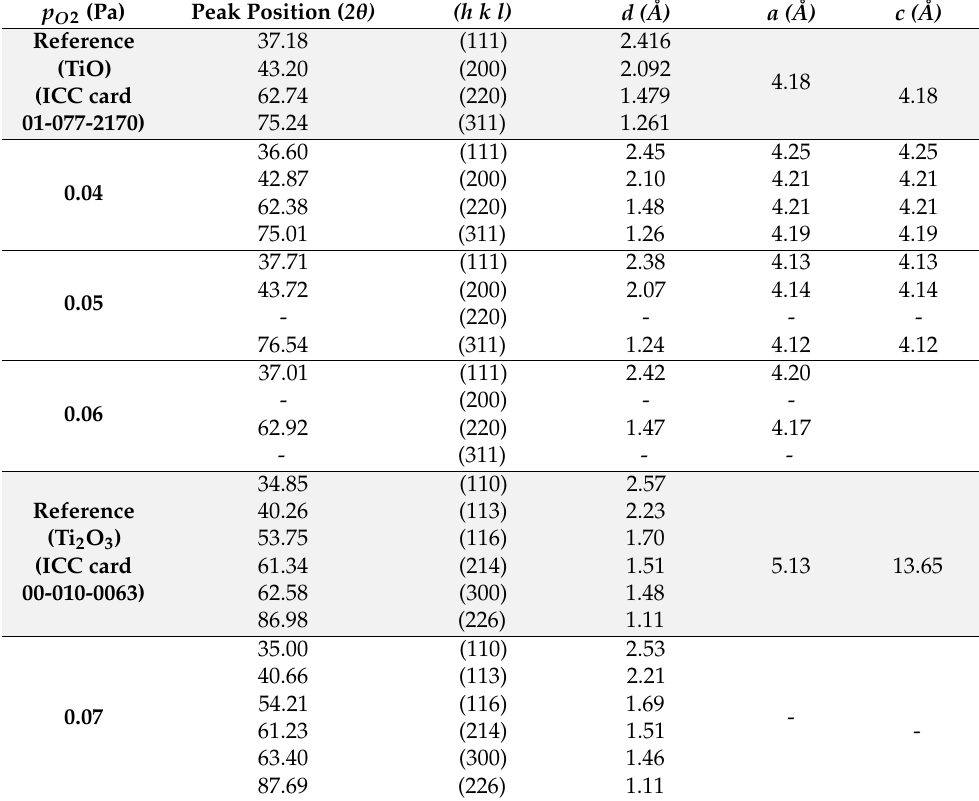
Table 1. Peak position, crystal planes, interplanar spacing, and lattice constants for TiO and Ti 2 O 3 reference cards and samples in group